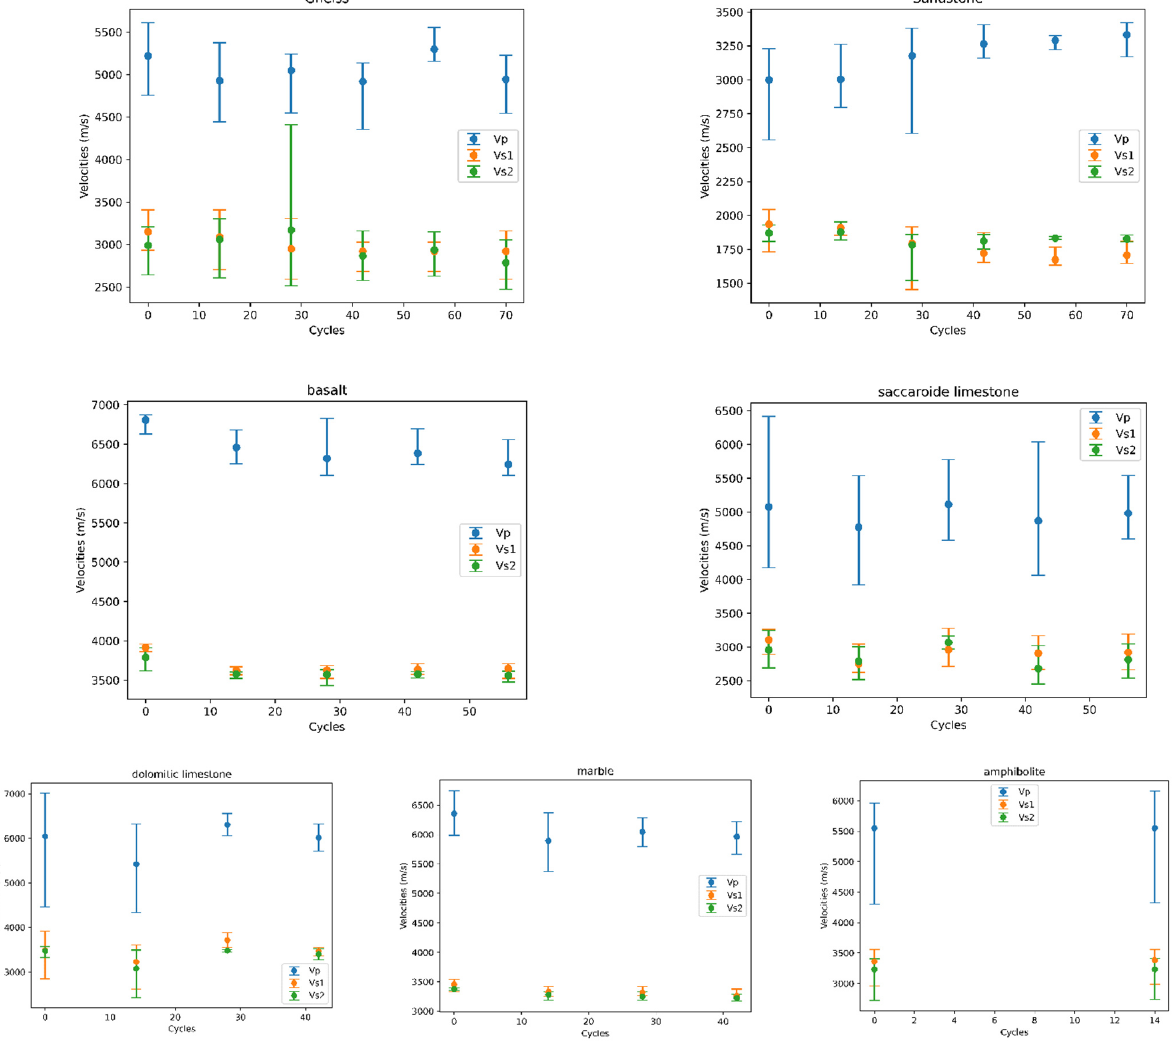
Figure 6. Evolution of the velocities of elastic waves for the tested rocks (Vp in blue, Vs1 in orange and Vs2 in green) max, mean and min values are given to illustrate the spread of results. The rock type is mentioned above each graph.